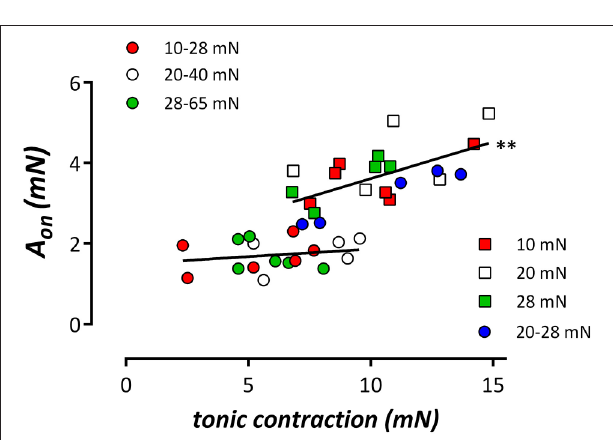
FIGURE 4 | Relationship between the amplitude of the phasic contraction (IP 3 contraction, A on ) by 2 µ M PE and the contraction induced by re-addition of extracellular Ca 2 + (tonic contraction) in the different stretch conditions. Linear regression revealed relationships with slopes (full lines), which were non-significantly different from zero for the segments cyclically stretched at normal/high amplitudes, but which were significantly different from zero in all other (low/static stretch) conditions. Both slopes were significantly different (pearson correlation, ** P <